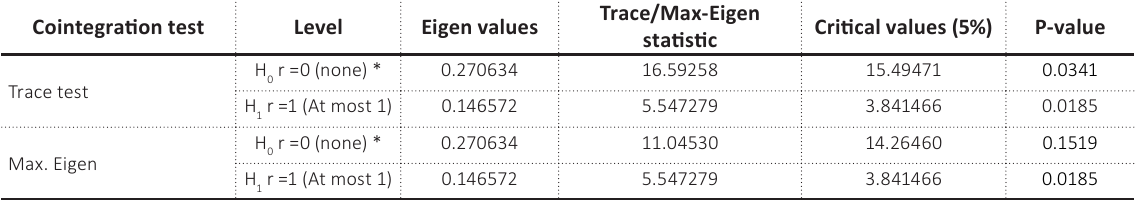
Source: EViews software